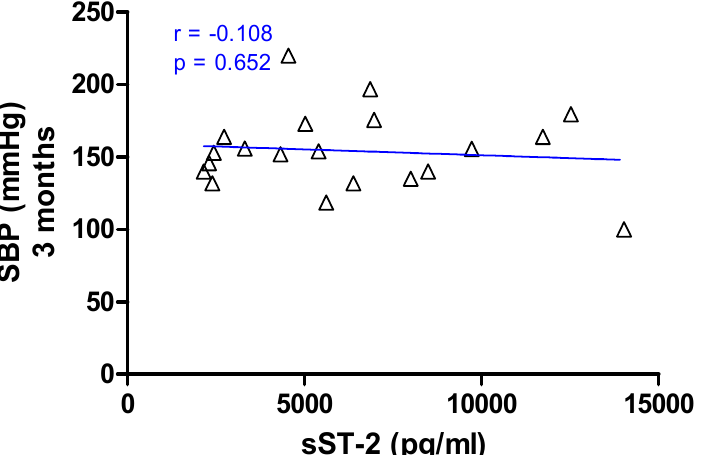
Figure 4. Pearson’s correlation of baseline sST-2 (sST2) with SBP three months after RSD revealed no significant correlation.